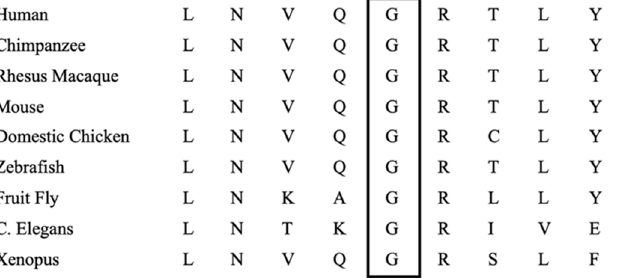
Figure 3. Schematic diagram depicting the mutational landscape of the IBA57 protein. Shaded boxes represent elements of protein secondary structure, and bars depict a previously reported variant at that loci. The p.Gly104Cys variant is shown in red. Pathogenic/likely pathogenic variants (P/LP) were obtained from both existing case reports/series and the ClinVar database. Benign/likely benign (B/LB) variants were obtained from the ClinVar database. The putative mutational hotspot is iden- tified as residues 96–112 (figure adapted from UniprotKB and Lebigot et al. (2021) [6]).